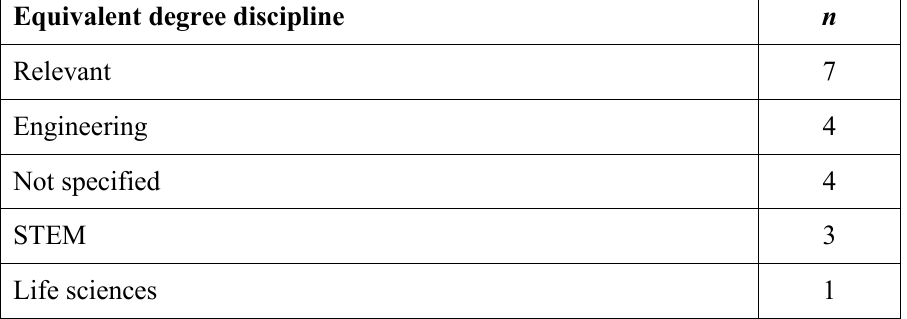
Table 3 : Discipline of equivalent degree required; Synonyms for relevant were related, appropriate, and comparable. Multiple disciplines could be